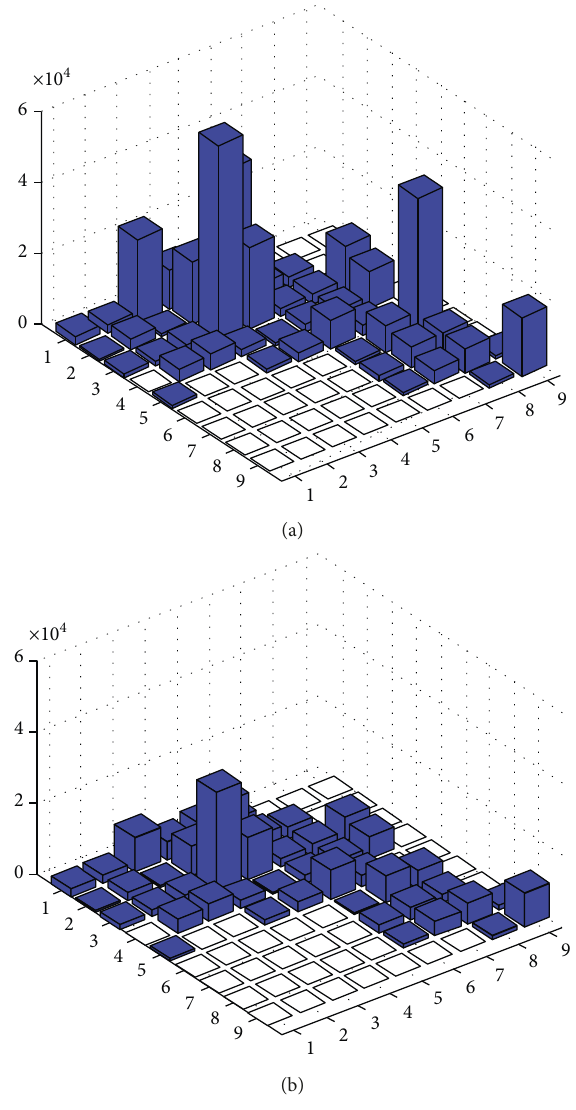
Figure 15: (a) Preintervention seismic risk and (b) post- intervention seismic risk of all